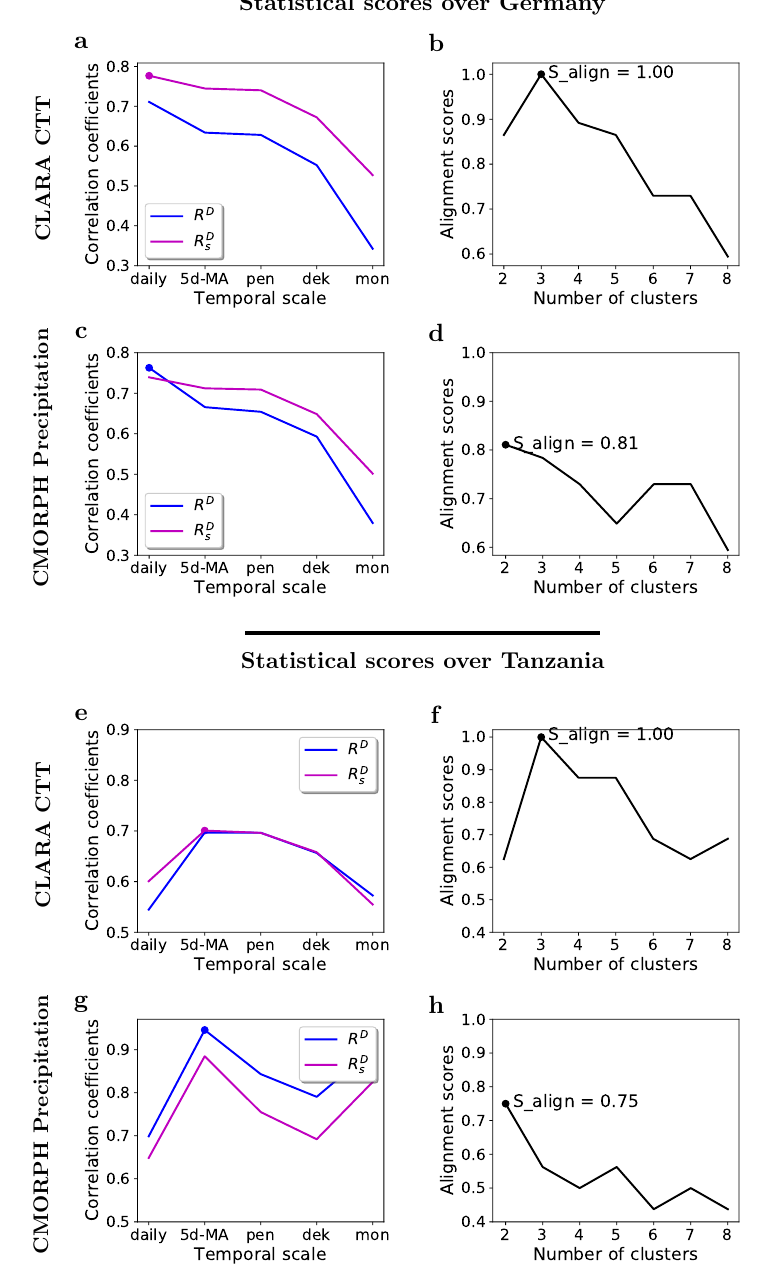
Figure 5. Statistical scores computed for CLARA CTT data and CMORPH precipitation data over Germany and Tanzania. The left column shows the criteria values (correlation coefficients) for selecting optimal temporal scales, with ( a , c ) computed respectively using CLARA and CMORPH data over Germany, and ( e , g ) respectively using CLARA and CMORPH over Tanzania. The right column shows the criteria values (alignment scores) for selecting numbers of clusters, with ( b , d ) computed respectively using CLARA and CMORPH data over Germany, and ( f , h ) respectively using CLARA and CMORPH over Tanzania. Dots in the plots represent the selections made by the